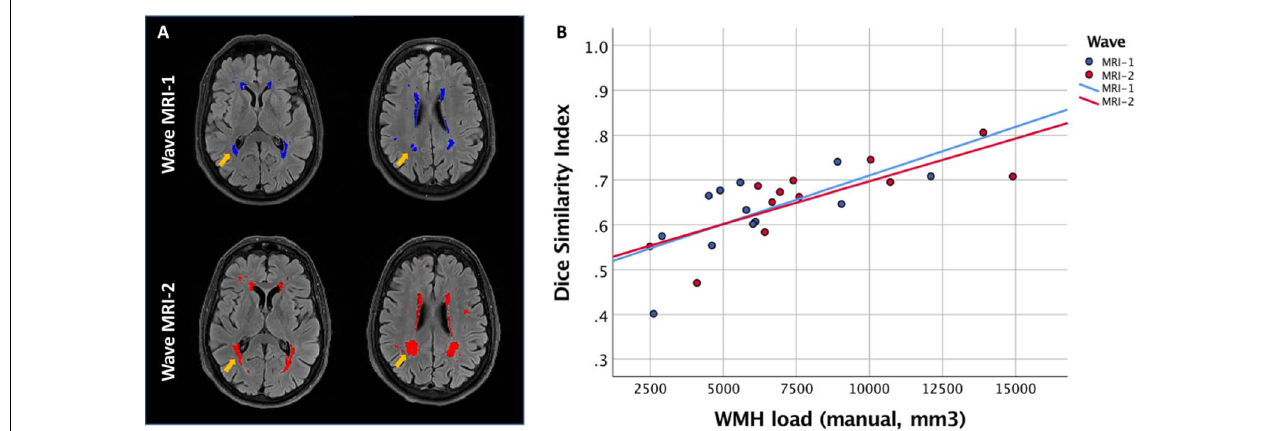
FIGURE 6 | White matter hyperintensity (WMH) lesion load. (A) Data from Heart and Brain Study participant showing automatically segmented WMH at Wave MRI-1 (2012-16, blue) and Wave MRI-2 (2019-23, red), using BIANCA. Yellow arrows indicate regions with noticeable increases in WMH between the two waves. (B) Scatter plot of BIANCA performance for 12 subjects, demonstrating that BIANCA performs similarly across the two timepoints. The Dice Similarity Index and manually segmented WMH load (mm 3 ) are plotted on the Y and X axes, respectively.